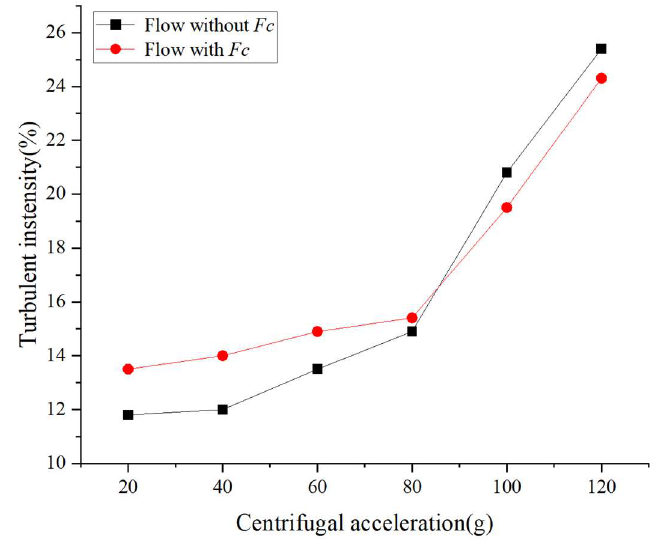
Figure 20. Turbulent intensity vs. the centrifugal acceleration.